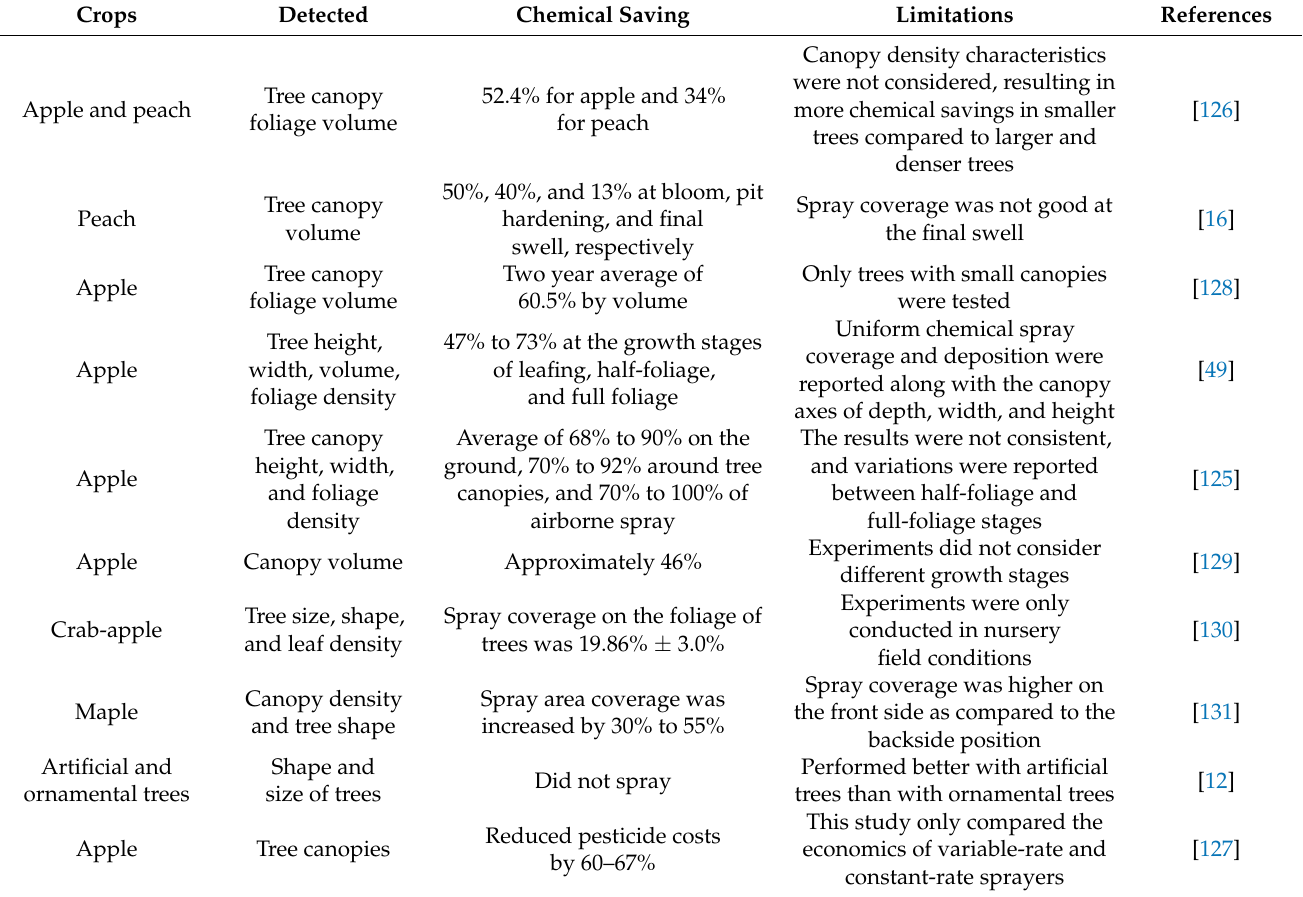
Table 5. Summary of laser sensor used in precision spraying in